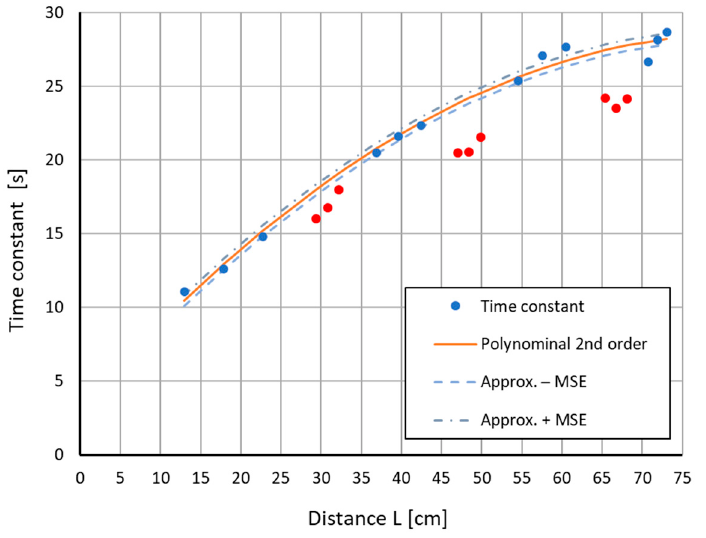
Figure 12. Approximation of the time constant ˆ T , depending on the distance L for points with a wall thickness of 5 mm (blue points), and time constants for points with a smaller wall thickness (red points).